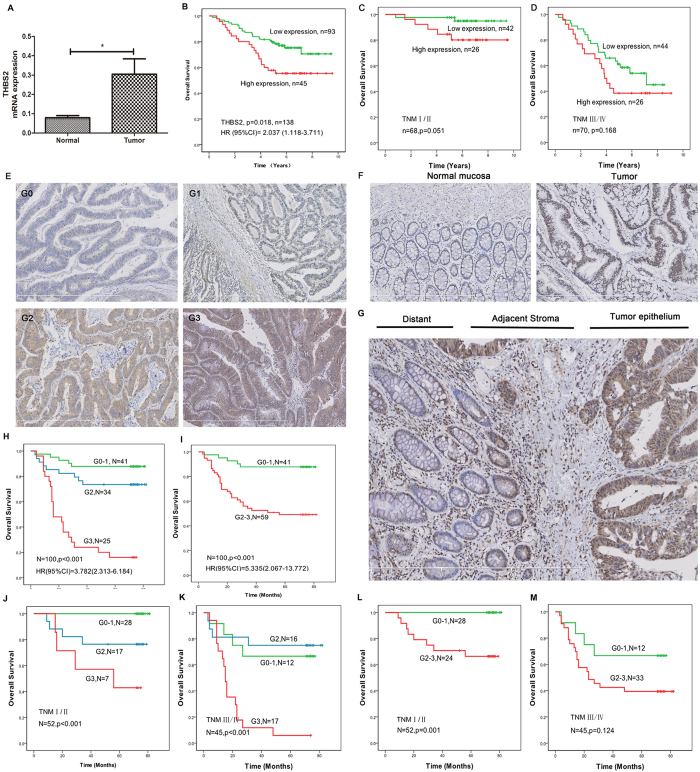
Expression of THBS2 in clinical colorectal tissues.(A) THBS2 mRNA expression in colorectal cancer tissues and paired adjacent normal tissues examined by qRT-PCR and normalized to GAPDH. (B) THBS2 high-expression predicts a poor prognosis for CRC patients by Kaplan-Meier survival curve. (C) Overall survival of THBS2 mRNA expression in TNM stage I/II. (D) Overall survival of THBS2 mRNA expression in TNM stage III/IV. (E) Representative images of THBS2 IHC of biopsies from human patients with CRC. Staining patterns were categorized into four grades (G0–G3). Scale bars, 600 um. (F) THBS2 protein expression in colorectal cancer tissues and paired normal mucosa examined by IHC. (G) THBS2 protein expression in distant, adjacent stroma and tumor epithelium. (H) Overall survival curves of G0-1, G1 versus G3 groups. (I) Overall survival curves of G0–G1 versus G2-3 groups. (J) Overall survival curves of G0-1, G1 versus G3 in TNM stage I/II. (K) Overall survival curves of G0-1 versus G2-3 in TNM stage III/IV. (L) Overall survival curves of G0-1 versus G2-3 in TNM stageI/II. (M) Overall survival curves of G0-1 versus G2-3 in TNM stage III/IV.